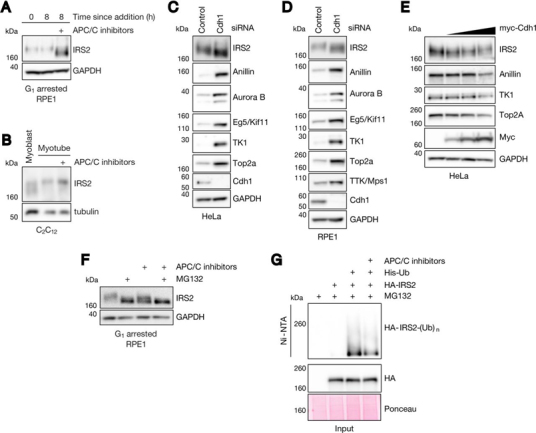
IRS2 levels are controlled by Cdh1 in a proteasome-dependent manner.A, Cells were treated identically to what is described in Fig. 1A, and IRS2 abundance was measured by immunoblot. B, C2C12 myoblasts were induced to differentiate through serum withdrawal and supplementation with insulin, transferrin, and selenium (ITS). After 3 days of differentiation, myotubes were acutely treated with either DMSO or APC/C inhibitors. After eight hours of drug treatment, myotubes were collected and IRS2 levels from all samples were analyzed by immunoblotting. C–D, Asynchronous HeLa (C) and RPE1 (D) cells were transfected with either a control or Cdh1-directed siRNA for 24 h. Cells were allowed to grow for an additional 24 h before collection and analysis of the indicated protein levels in lysate by immunoblot. E, HeLa cells were mock transfected or transfected with increasing amounts of a plasmid encoding myc-tagged human Cdh1 for 24 h. Cells could grow for an additional 24 h before collection and analysis of the indicated protein levels by immunoblot. F, RPE1 cells were arrested in G1 with 1 μm palbociclib for 20 h. Following G1 arrest, cells were treated with DMSO, APC/C inhibitors, MG132, or a combination of APC/C inhibitors and MG132 for an additional 8 h. Cells were harvested, and lysates were analyzed by immunoblot for IRS2 abundance. G, 6xHis-tagged ubiquitin conjugates were isolated from HeLa cell lysates using Ni-NTA agarose resin. Lysates were derived from cells expressing 6xHis-ubiquitin and HA-tagged IRS2 that were treated with MG132 alone or in combination with APC/C inhibitors. Resin eluate and inputs were probed by immunoblot using an HA antibody, and Ponceau staining was used as a loading control.